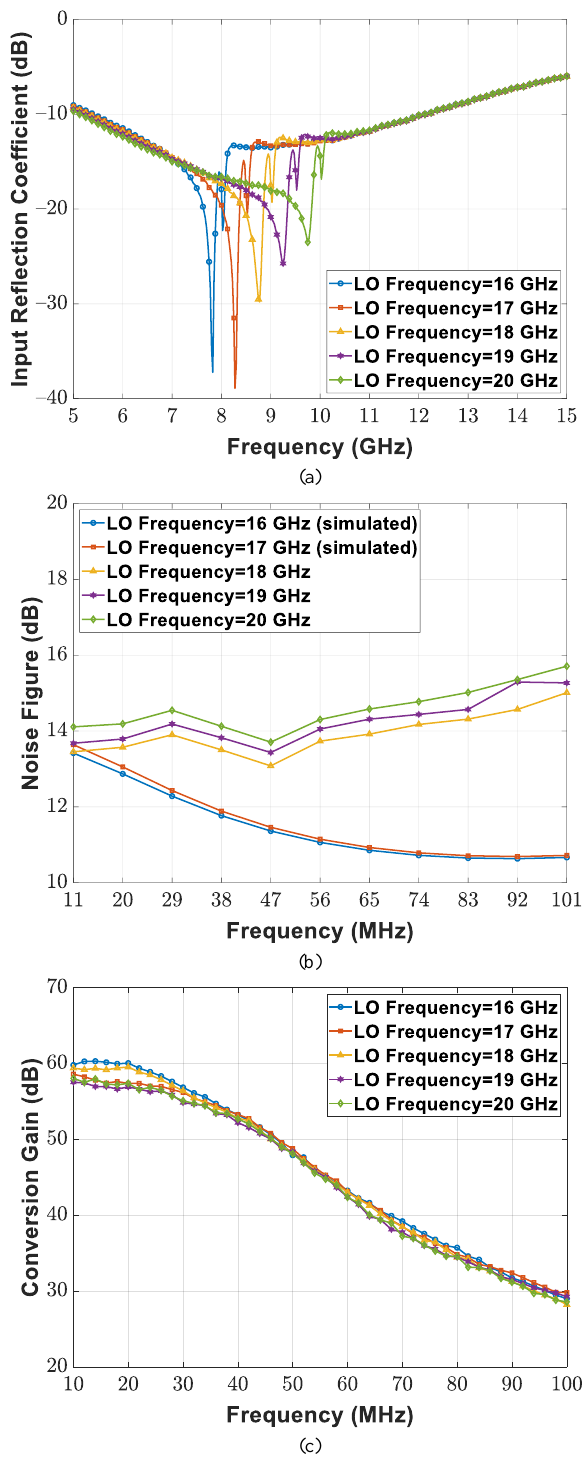
Figure 22. Circuit performance of the implemented receiver, including ( a ) input reflection coefficient, ( b ) noise figure, and ( c ) conversion